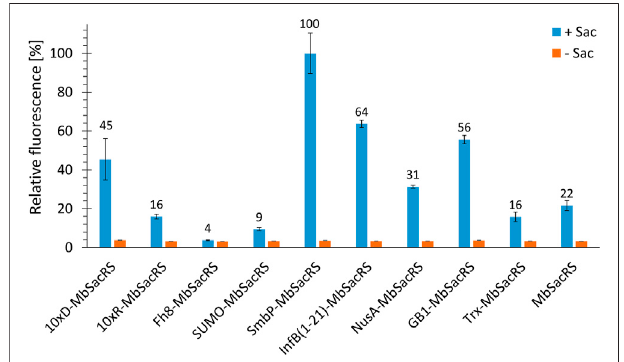
FIGURE 3 | OTS ef fi ciency comparison of 10 different Mb SacRS constructs measured via intact cell fl uorescence of E. coli BL21 (DE3) expressing the sfGFP(R2 amber) construct. Reporter signal stems from stop codon suppression in presence (+Sac (cid:1) 2 mM) or absence of ncAA supplementation ( −